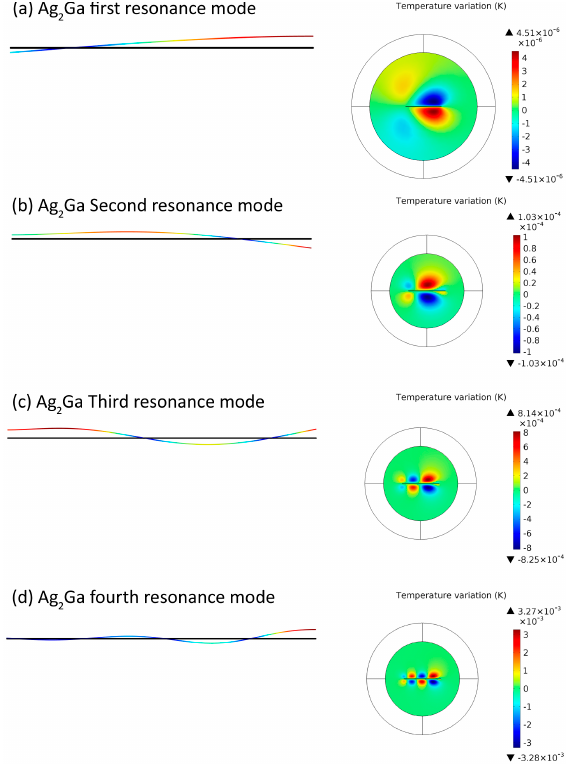
Figure 5. Mode shape and temperature variation for different modes of AgGa nanoneedle.